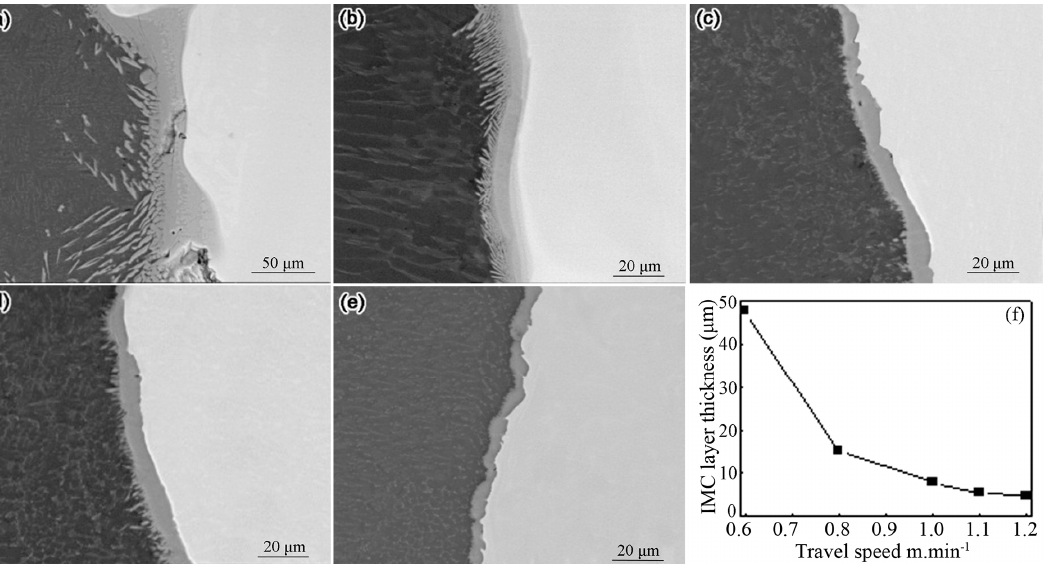
10 of 18 Figure 9. EBSD phase mappings of the interface of Al/steel joints at a laser beam offset of 0.3 mm. 3.5. Morphology and Thickness of IMC Layers Figure 10 shows the BSE micrographs of the IMC layers at the interface of the Al/steel butt joints with different travel speeds. At a travel speed of 0.6 m/min, the IMC morphology formed at the interface exhibits a number of large needle-like FeAl 3 phases and thick Fe 2 Al 5 layers owing to the high heat input induced by the slow travel speeds. With the increase of travel speeds from 0.8 to 1.2 m/min, the quantity of large needle-like FeAl 3 phases was significantly decreased and the thickness of the Fe 2 Al 5 layers was also reduced. In particular, the large needle-like FeAl 3 phases dispersed in the Al